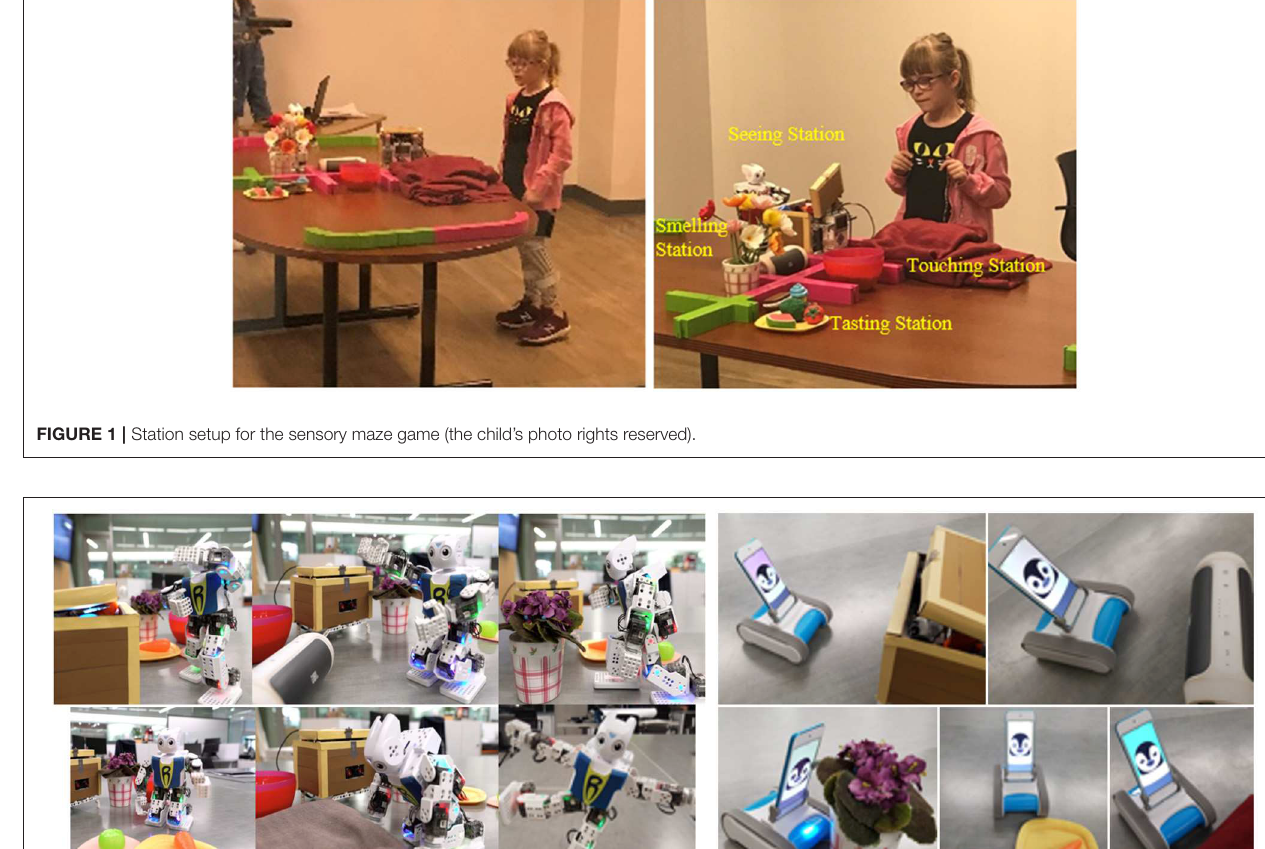
Frontiers in Robotics and AI |